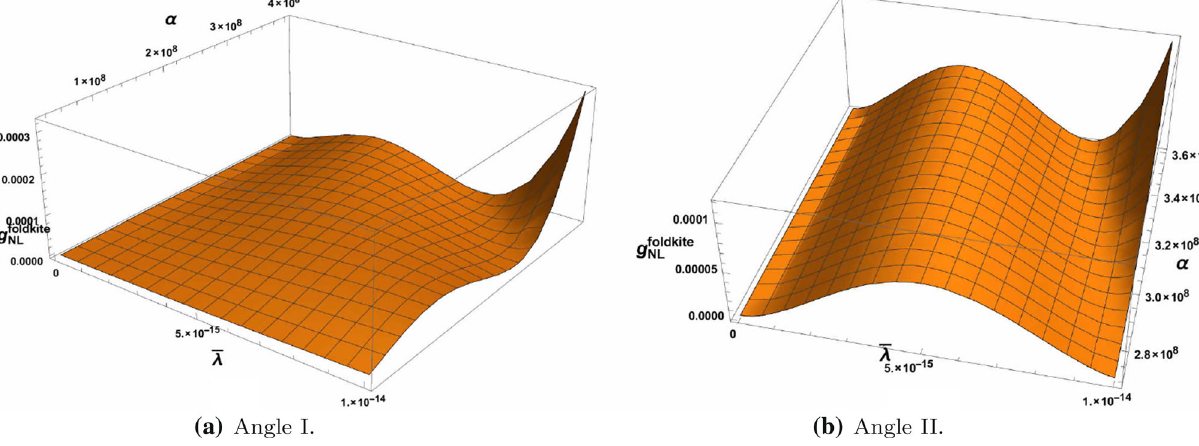
Fig. 29 Representative 3D diagram for equilateral non-Gaussian three point amplitude vs. the model parameters α and ¯ λ for N cmb = 60 in two different angular